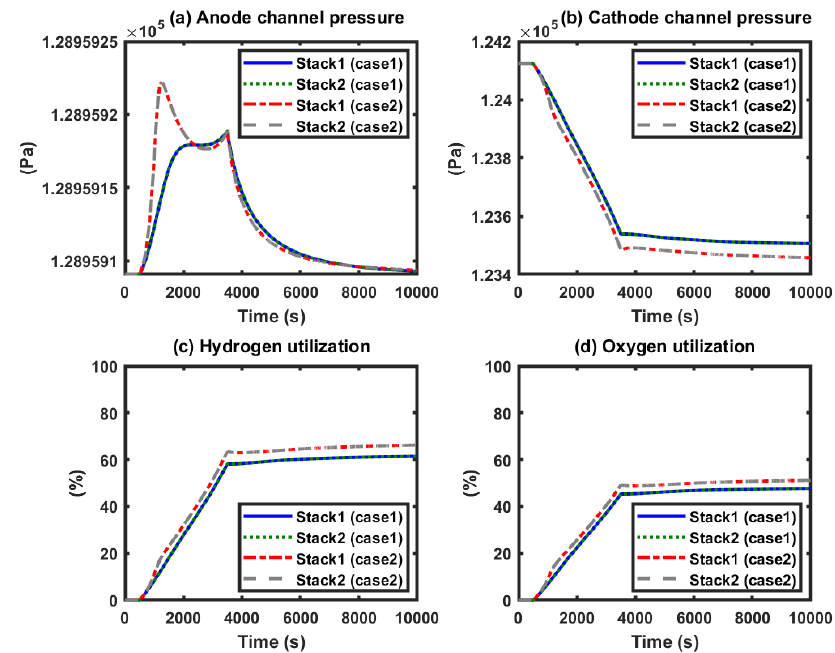
Figure 6. Transient response of the channel pressures and fuel utilizations when the two employed FC stacks are the same. Case 1: stacks have a small ohmic loss. Case 2: stacks have a large ohmic loss. ( a ) Anode channel pressure, ( b ) cathode channel pressure, ( c ) hydrogen utilization, and ( d ) oxygen